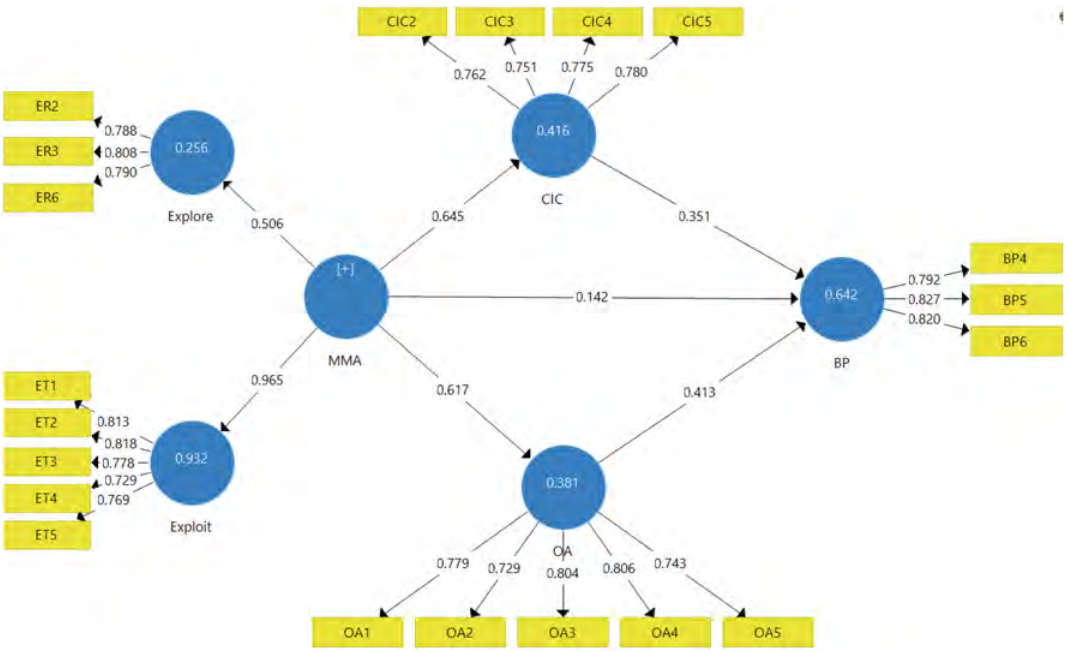
Figure 3. Loading factors of operational performance model